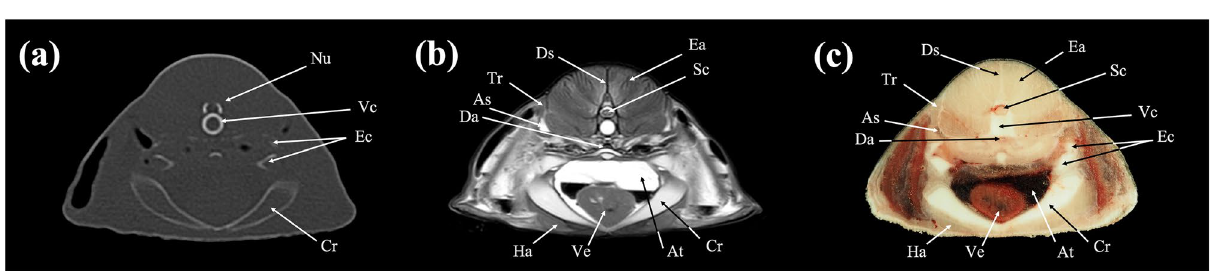
Figure 6. Transverse ( a ) CT, ( b ) MR, and ( c ) cryosection images of a banded houndshark ( Triakis scyllium ) at level 6 of Fig. 25. As Anterior cardinal sinus, At Atrium, Cr Coracoid bar, Da Dorsal aorta, Ds Dorsal median septum, Ea Epaxial, Ec Epibranchial and ceratobranchial cartilage, Ha Hypaxial, Sc Spinal cord, Tr Trapezius, Ve Ventricle, Vc Vertebral